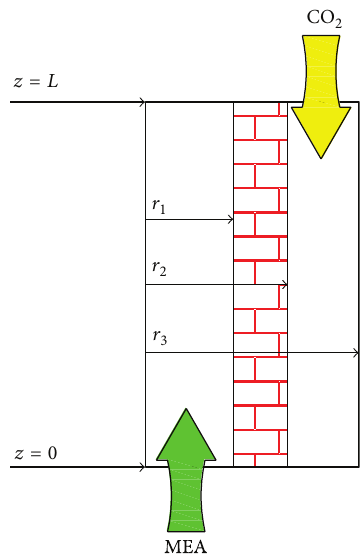
Figure 1: A schematic diagram of a hollow fiber membrane